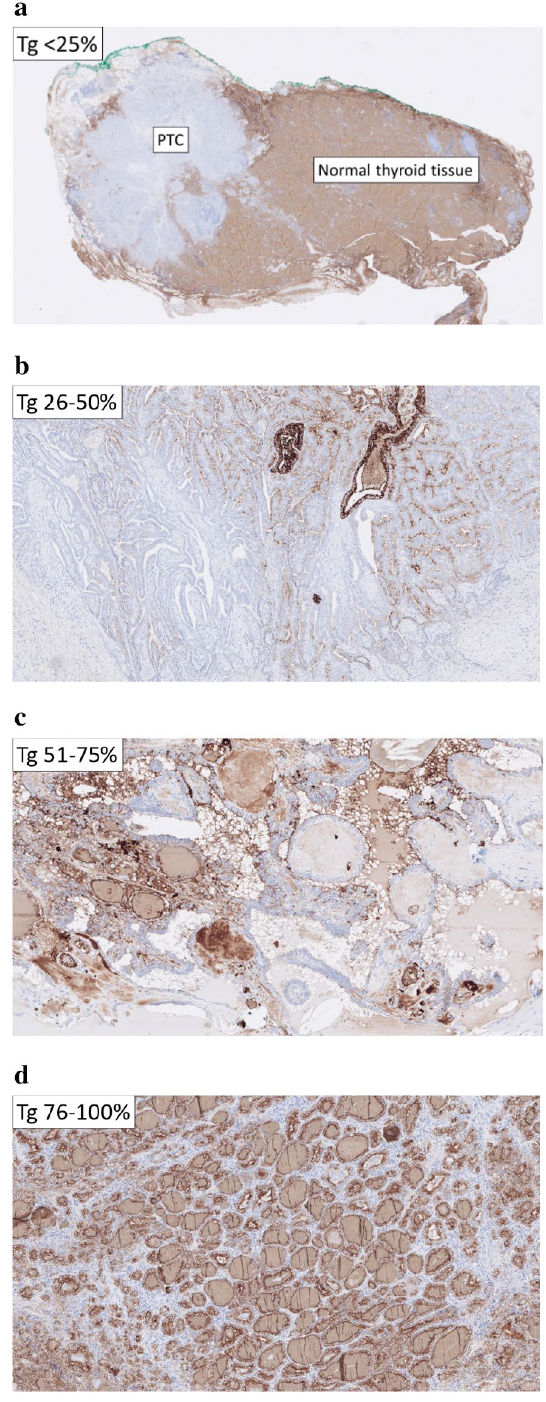
Figure 1. Histological images representative of each semi-quantitively graded group of thyroglobulin immunostaining confined to tumor cells in papillary thyroid cancer ( a ) 0–25%, ( b ) 26–50%, ( c ) 51–75%, and ( d ) 76–100% stained tumor